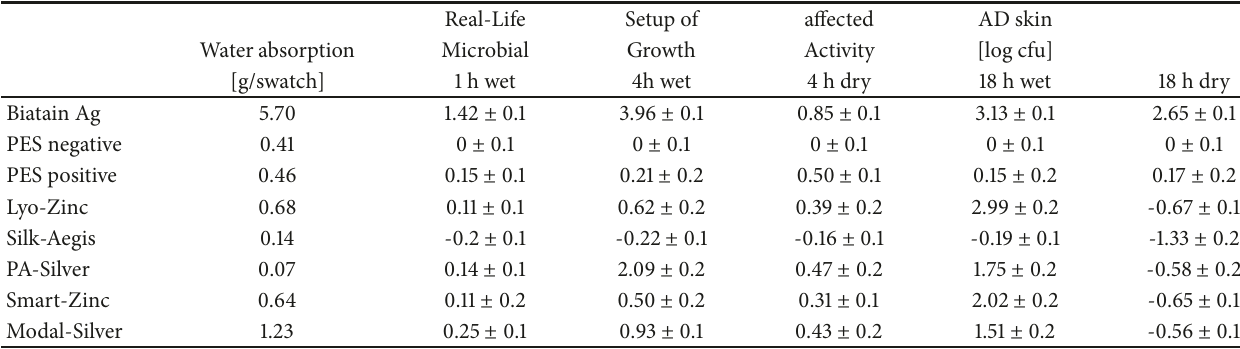
Table 2: Comparison of antibacterial activity of conventional AD fabrics subjected to the S. aureus inoculated artificial skin. Results depicted as log 10 reduction factors, means of triplicates with SDs. The zinc-containing samples displayed considerable stronger antibacterial activities after 18 h followed by the silver-containing samples, but only when the samples were prewetted to their individual water absorption capacity. No short-term effect (1 h) of wetted samples on colonized skin was observed.